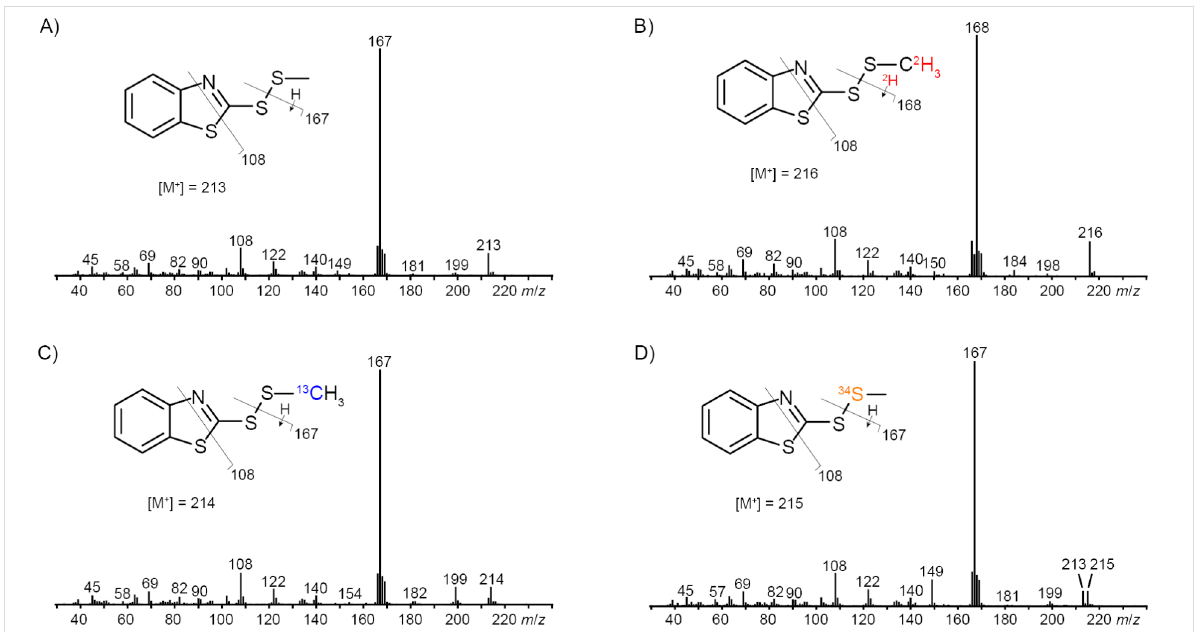
Figure 3: EI mass spectra of A) unlabeled 2-(methyldisulfanyl)benzothiazole ( 41 ) and of labeled 41 after feeding of B) ( methyl - 2 H 3 )methionine, C) ( methyl - 13 C)methionine and D) ( 34